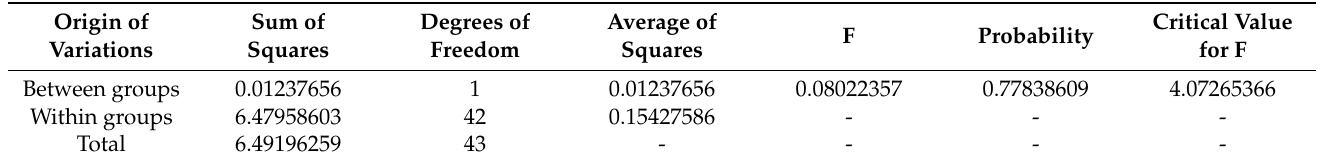
Table 2. Analysis of variance.